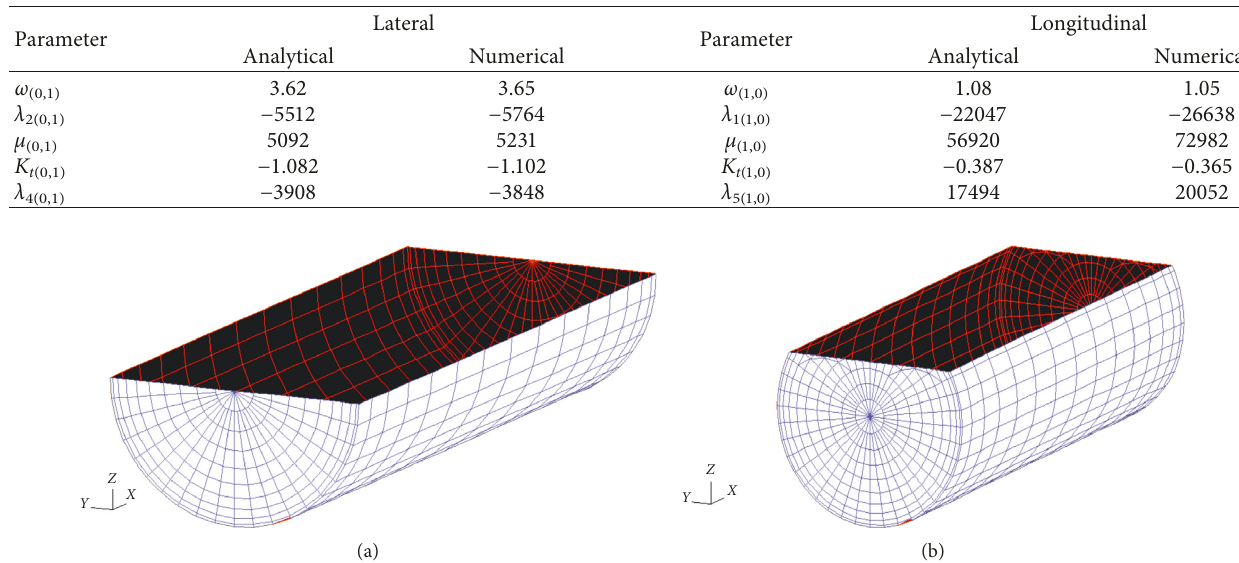
Figure 3: Added mass calculated by HydroSTAR: (a) A Table 1: Hydrodynamic coefficients calculated by analytical and numerical methods.